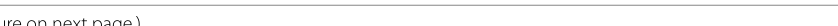
figure on next Fig. 3 Empirical evidence on overissuing. Notes: The data have an annual frequency. The annual average of the exchange rate between the Swiss and the French franc of the top panel covers the 1851–1913 period and is taken from Table 21 of Jöhr (1915, p.509), who has compiled these data from various sources (see Jöhr, 1915, p.418). The consumer-price index of the top panel covers the 1826–1913 period and has been taken from Table H39 of the 2012 edition of the Historical Statistics of Switzerland (see www. hsso. ch). In the middle panel, the banknotes in circulation (e.g net of banknotes held as reserves by note-issuing banks) per capita have been compiled from Tables DB11 and DB15 of Flandreau and Zumer (2004). The price indices of the bottom panel have been taken from Table DB13 of Flandreau and Zumer (2004). To reflect the effect of regulated free banking, these indices have been re-based, such that 1881 =